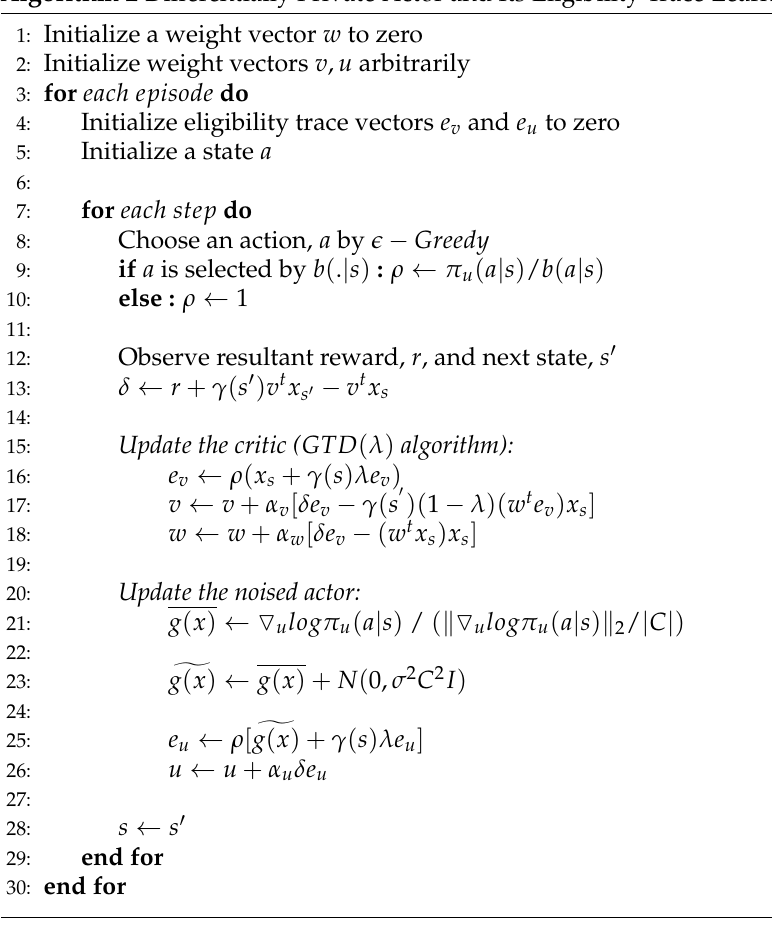
Algorithm 2 Differentially Private Actor and Its Eligibility Trace